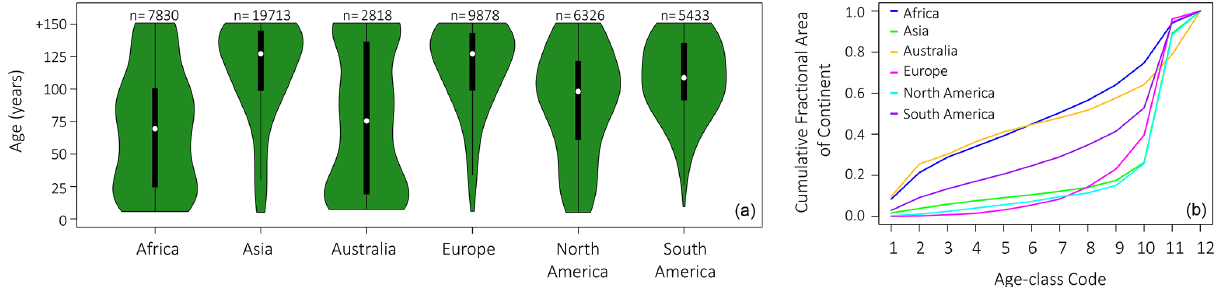
Figure 7. Age-class distributions by continent. (a) Violin plots of ecosystem age by continent averaged over 2000–2010, based on LPJ-wsl v2.0 simulations. Violin plots show the distribution of data points (green), interquartile range (black box), and the median value (white circle). The number of vegetated 0.5 ◦ grid cells in each continent are above the plot. (b) Cumulative fractional area in continent by age classes. Age-class codes, lowest (youngest) to greatest (oldest), correspond to the 10-yr-equalbin age-class setup (Table